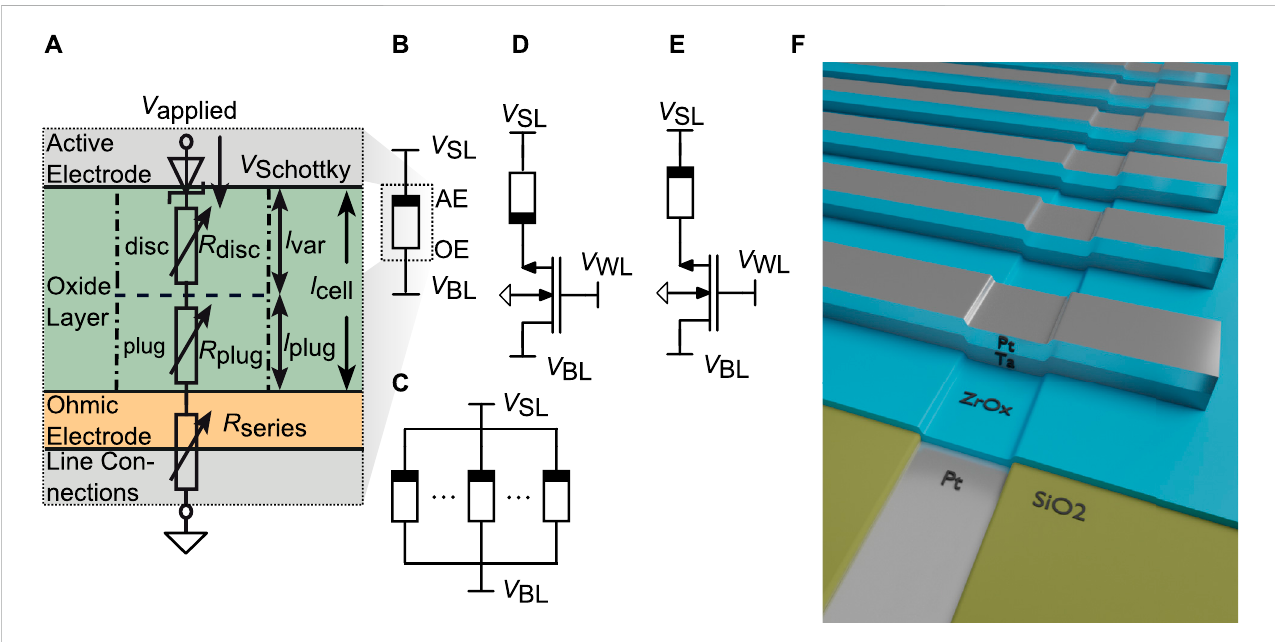
FIGURE 1 (A) Equivalent Circuit Diagram (ECD) of the JART VCM v1b model and the different considered synapse structures (B – F) . (B) shows the 1R synapse (C) shows the N R synapse, (D) shows the 1T1R in con fi guration AE at transistor and (E) shows the 1T1R con fi guration OE at the transistor. For the synapses containing a transistor the Bulk connections of the transistors are connected to GND. (F) shows the device structure used for the experimental